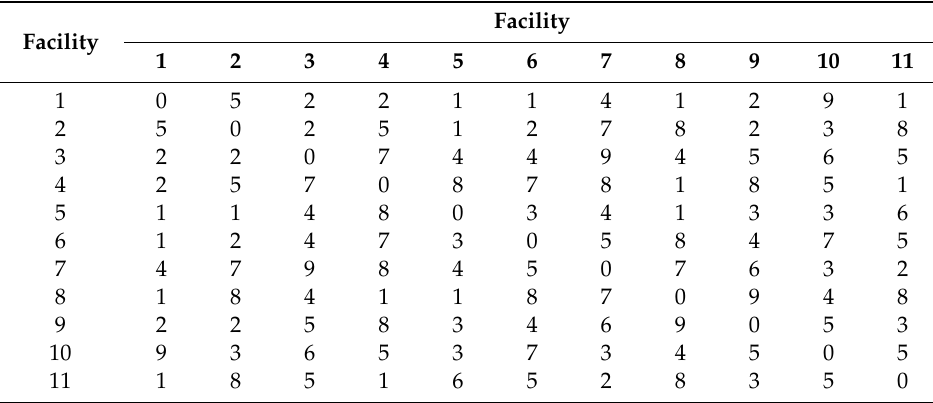
Table 1. Frequencies of trips between facilities.